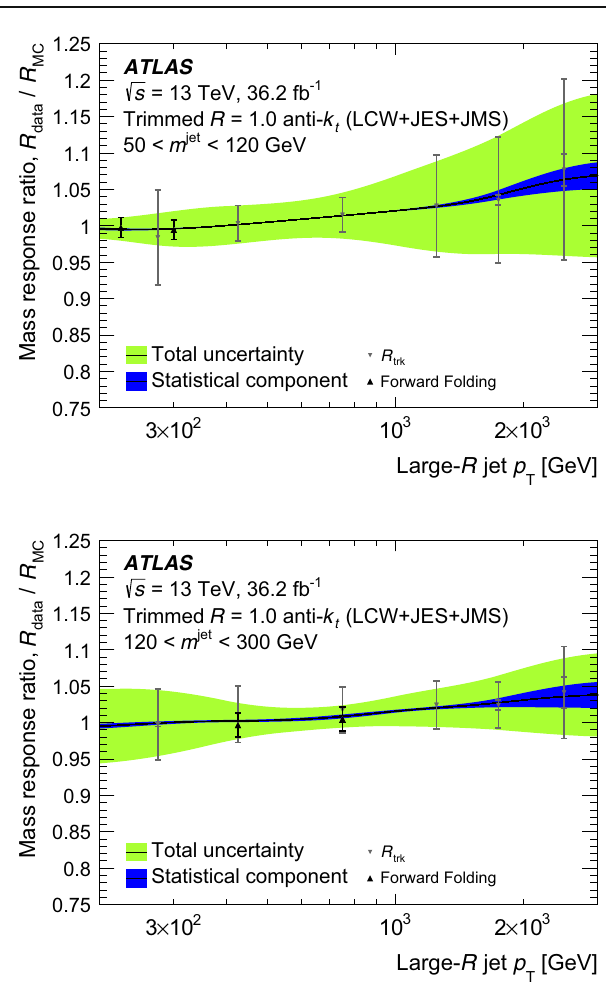
Fig. 30 Data-to-simulation ratio of the average jet mass response as a function of the large- R jet p T . Corrections using a combination of two in situ methods, the R trk and forward-folding approaches, are applied. The fit is performed for large- R jet mass in the W mass range 50– 120 GeV (upper), and the top mass range 120–300 GeV (lower). The error bars represent the statistical and systematic uncertainties added in quadrature. The results apply to anti- k t jets with R = 1 . 0 calibrated with the LC+JES+JMS scheme. The lines shown are smoothed using a sliding Gaussian